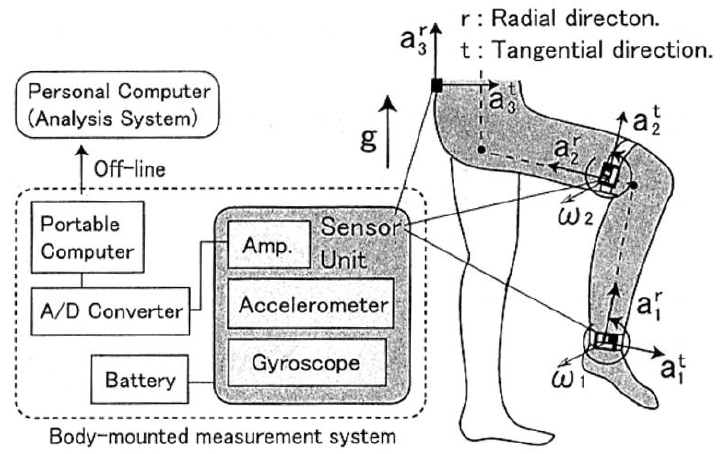
Figure 2. Accelerometer positioning and biomechanical model as designed by [26].